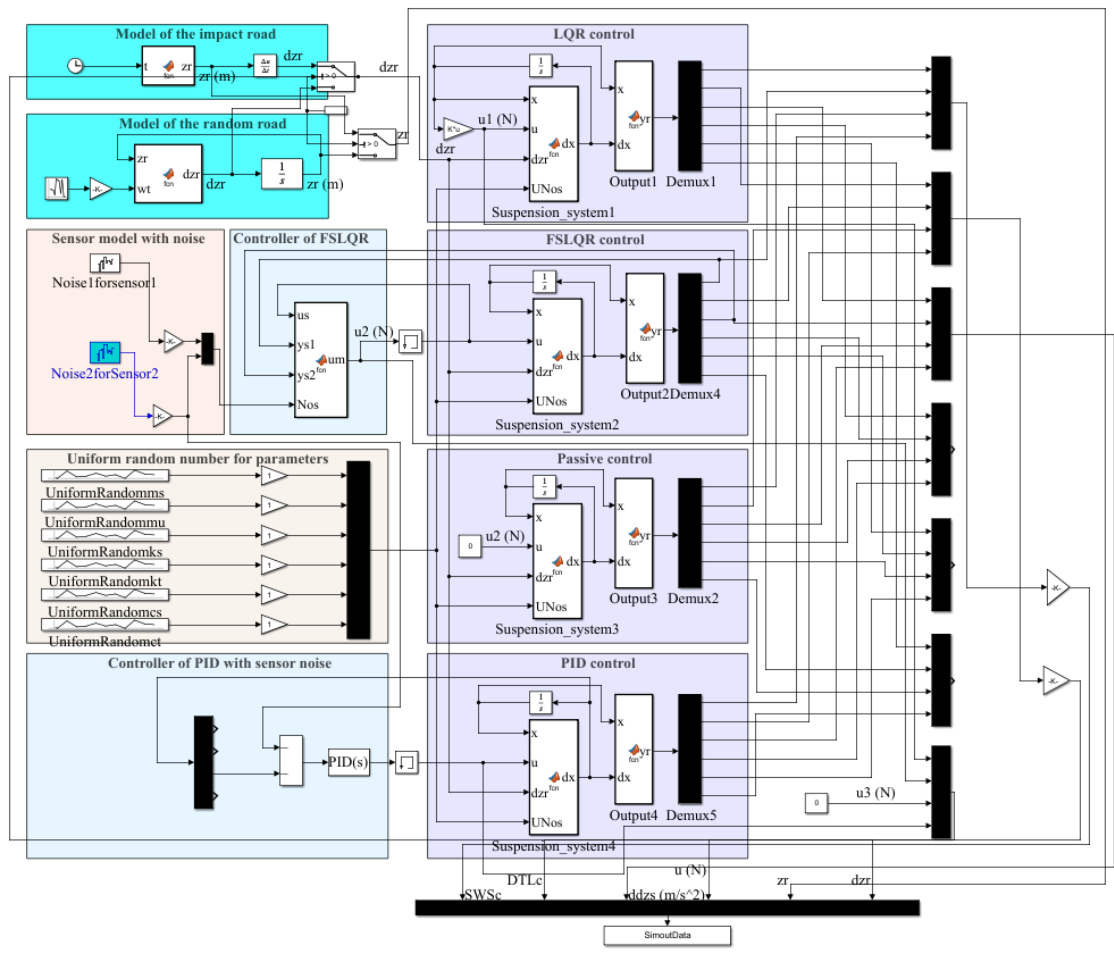
Figure 2. Quarter car suspension model. Table 1. The dynamics parameters of the suspension system.